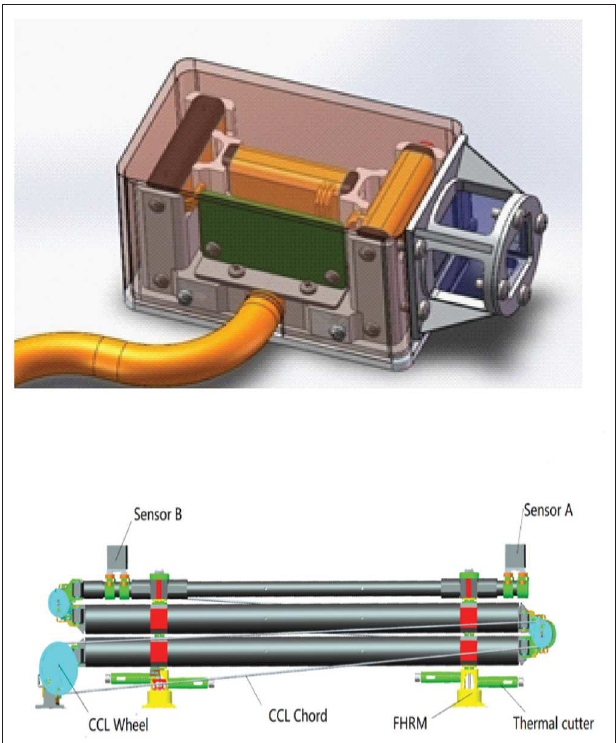
FIGURE 6 | Configuration of MAG: (Top) the MAG sensor; (Bottom) boom.